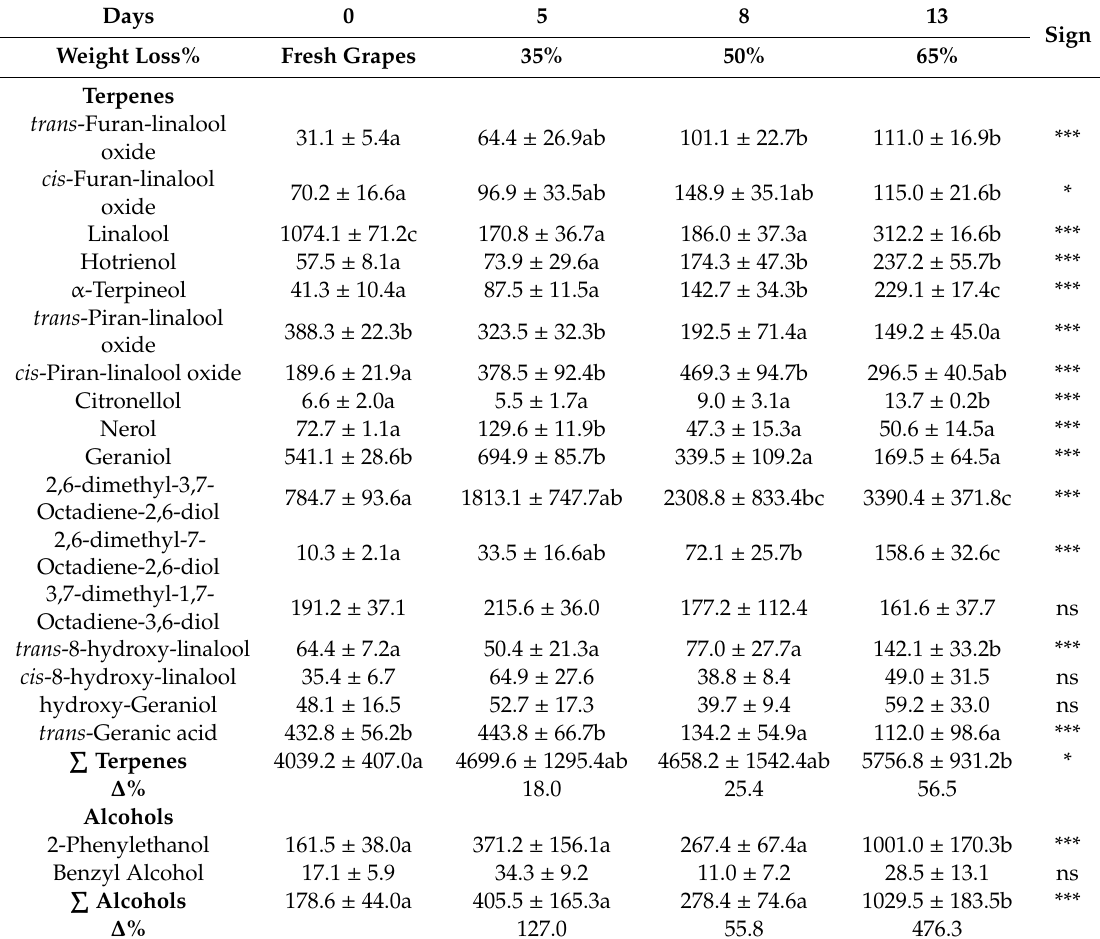
Table 3. Evolution of free volatile compounds of Muscat Alexandria grapes during dehydration ( µ g / kg